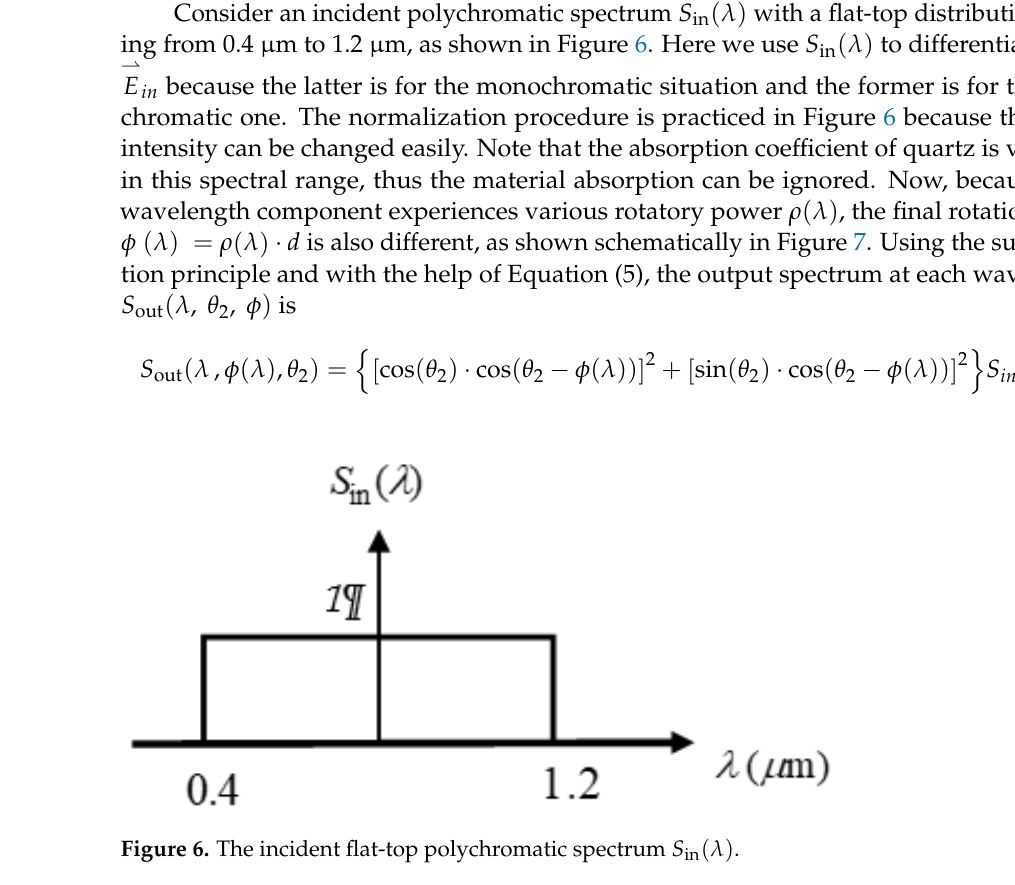
Figure 6. The incident flat-top polychromatic spectrum